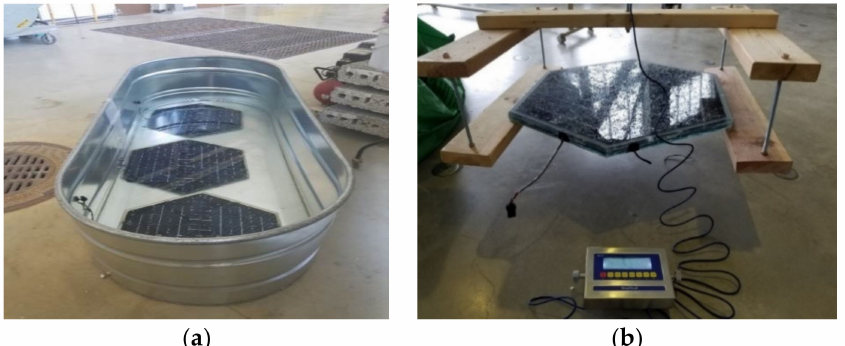
Figure 5. Moisture conditioning duration testing: ( a ) single 1135.62 litter aluminum container used during the SRP moisture conditioning duration testing. The paver electrical connectors were fixed above the waterline during testing; ( b ) test apparatus for weighing the solar road panels (SRPs) before and after each moisture conditioning